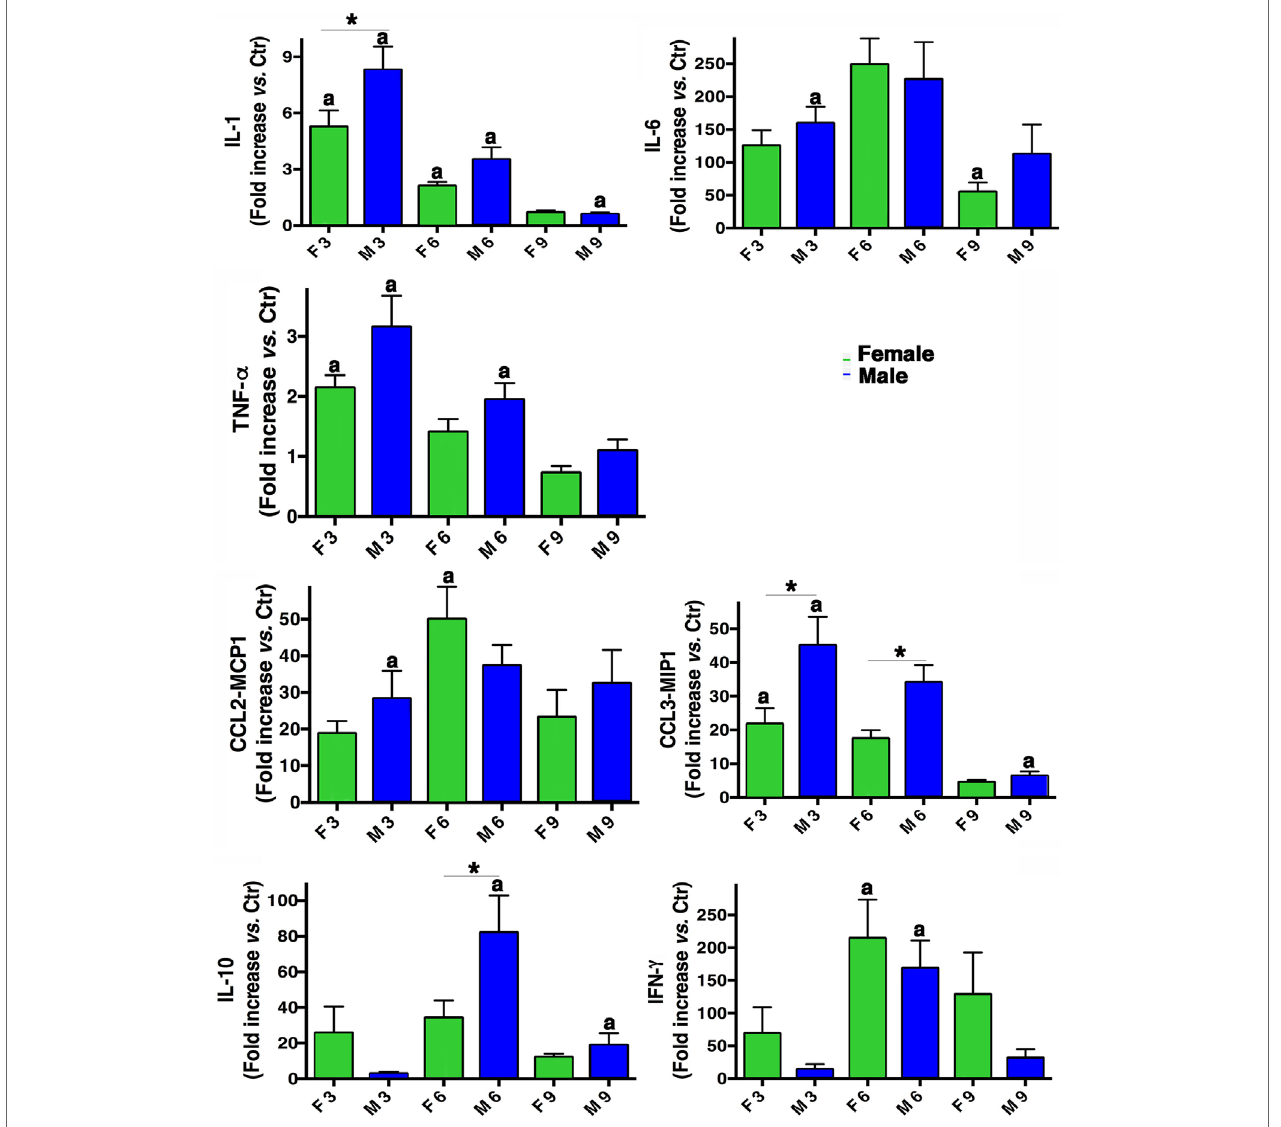
FigUre 4 | Inflammatory cytokine production in infected mice. BALF concentrations of IL-1, IL-6, TNF- α , IL-10, IFN- γ , CCL2-MCP1, and CCL3-MIP1 were measured in male (M) and female (F) mice from the mock-infected (Ctr) and PR8-infected groups. The data (mean ± SEM) are represented as the concentration of cytokines at days 3, 6, and 9 p.i. relative to Ctr. Results are obtained from five different experiments, each performed with seven male and seven female mice. * p -Value < 0.05 (female vs. male group); a p -value < 0.05 (differences within a sex across time-points